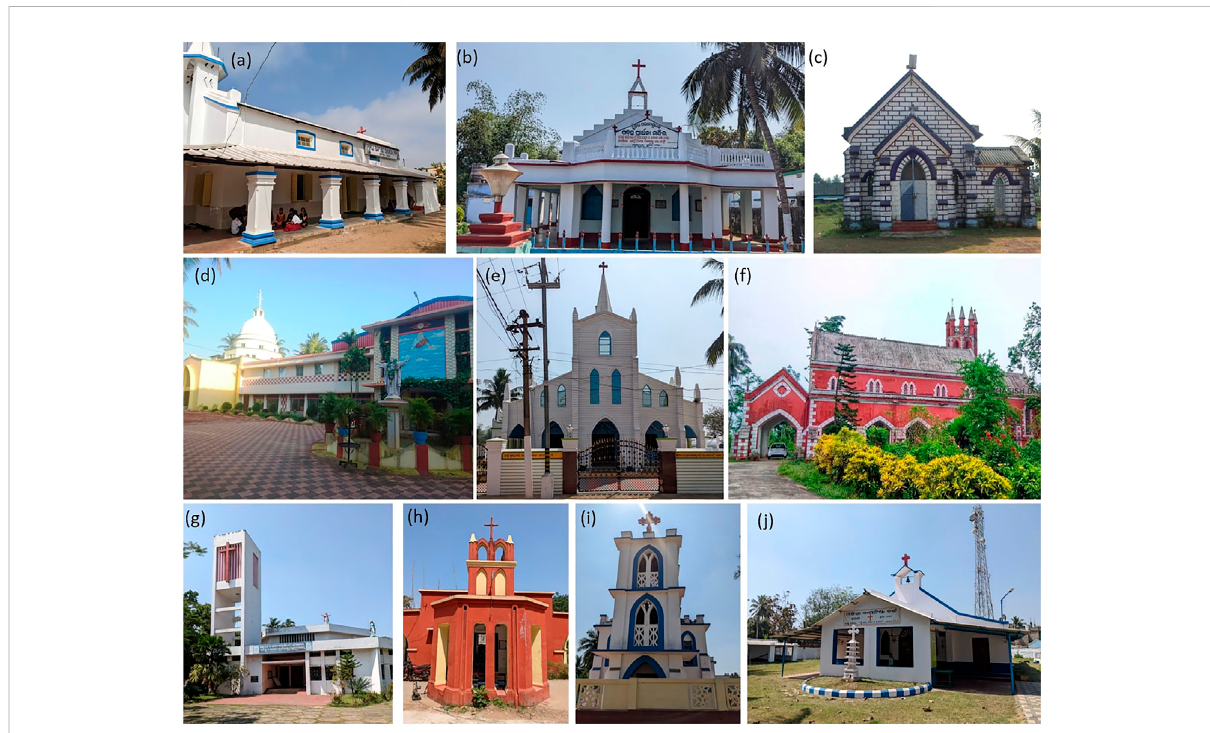
FIGURE 2 (A) Pipili Baptist Church, Pipili (B) Ashraya Pur, Jamkouli (C) St. John Church, Jatni (D) St. Vincent Pro ’ s Cathedral, Bhubaneswar (E) Bahilipada Church,Barakuda (F) ChurchofEpiphany,Cuttack (G) OurLadyofMostHolyRosaryCathedral, Cuttack (H) MountHouseChurchofGod,Cuttack (I) Sacred Heart Church, Jatni (J) Oriya Baptist Church,